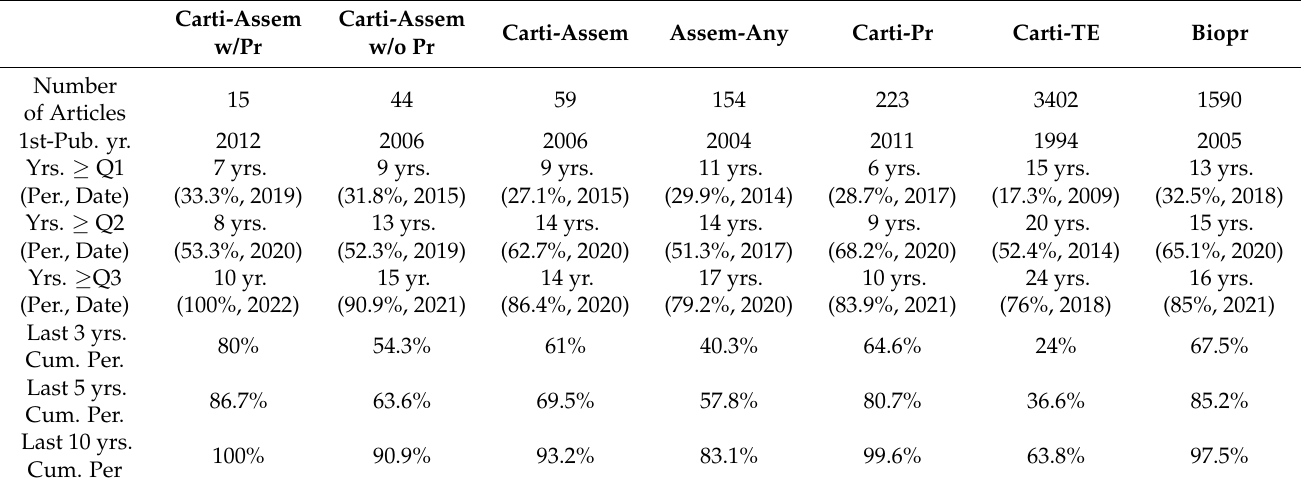
Table 3. Summary of Milestones in the Literature Analysis.